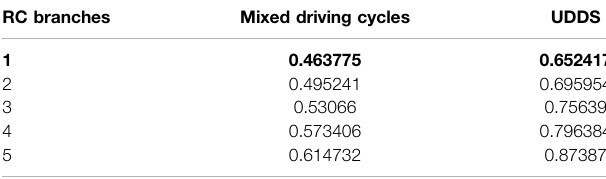
TABLE 23 | Time consumption of the augmented ECM-based H-in fi